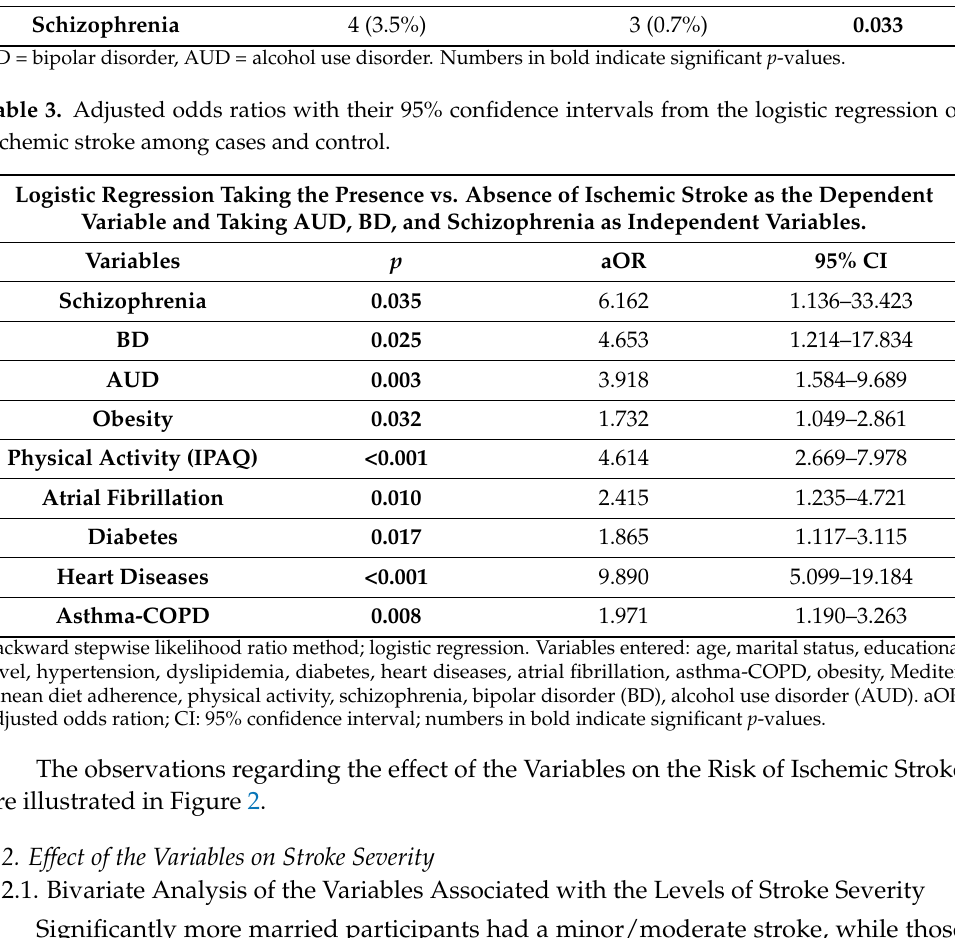
Table 2. Bivariate analysis of other factors associated with ischemic stroke. Presence of Ischemic Stroke Absence of Ischemic p -Value Variable (N = 113) Stroke (N = 451) Mean ± SD AUD 3.8 ± 2.7 3.1 ± 1.8 0.014 BD 2.6 ± 2.8 1.8 ± 1.9 0.003 N (%) Schizophrenia 4 (3.5%) 3 (0.7%) 0.033